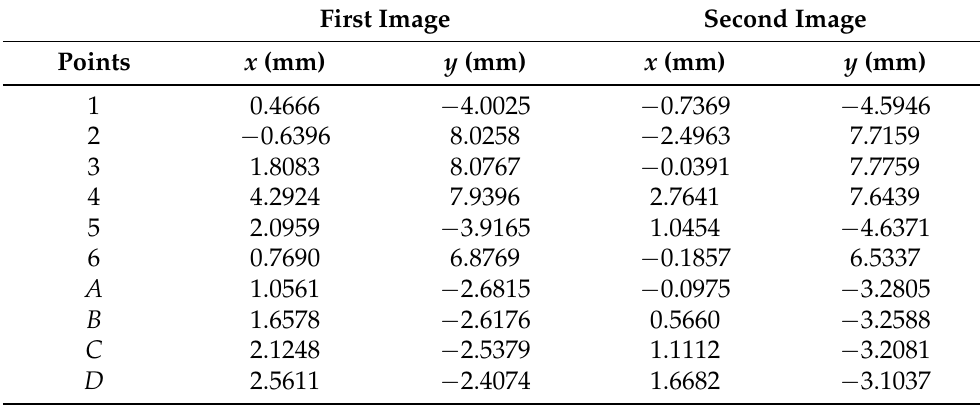
Table 8. Image plane coordinates of the two images in second